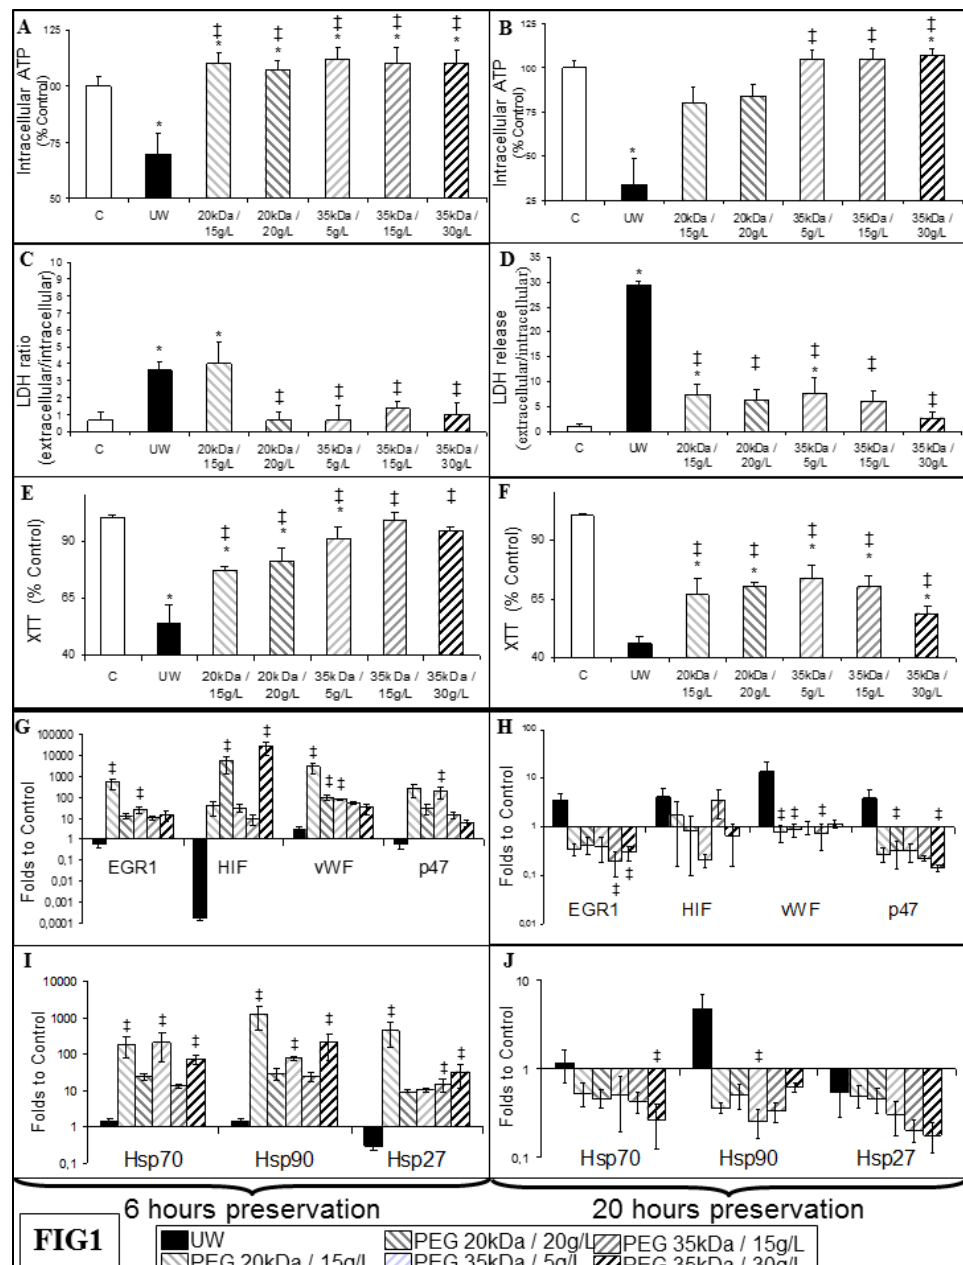
Figure 1. In vitro evaluation of endothelial cell resistance to ischemia–reperfusion injury (IRI). Primary porcine endothelial cells underwent 6 h ( A , C , E , G , I ) or 20 h ( B , D , F , H , J ) hypoxia in University of Wisconsin (UW) or polyethylene glycol (PEG) solutions. ( A , B ) Cellular adenosine triphosphate (ATP) content expressed as percentage of ATP in control cells (no hypoxia); ( C , D ) Cell death determined by calculating the ratio between extracellular over intracellular Lactate DesHydrogenase (LDH); ( E , F ) Mitochondrial Succinate Deshydrogenase activity assessment by 2,3-bis-(2-methoxy-4-nitro-5-sulfophenyl)-2 H -tetrazolium-5-carboxanilide (XTT) assay, expressed as percentage of viability in Control cells (no hypoxia); ( G , H , I , J ): RTqPCR evaluation, mRNA expression is calculated as folds to control cells. Control are cells incubated in regular medium for 48 h. Shown are mean + SEM. Statistics: * p < 0.05 versus Control; ‡ p < 0.05 to UW. n = 3.